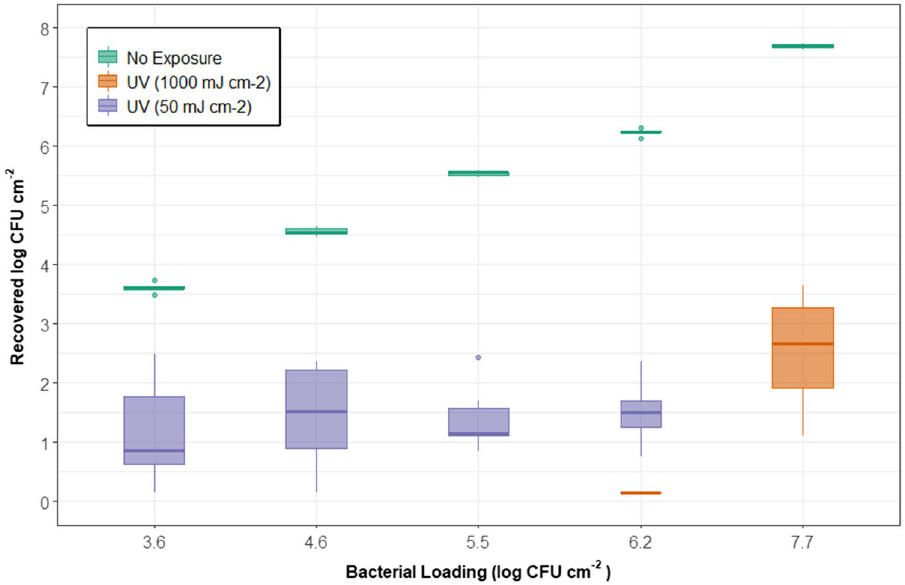
Figure 5. Relative effects of P. aeruginosa cell-density on 9210 FFR coupon LRVs. Each boxplot represents each of 2 technical replicates for each of 2 biological